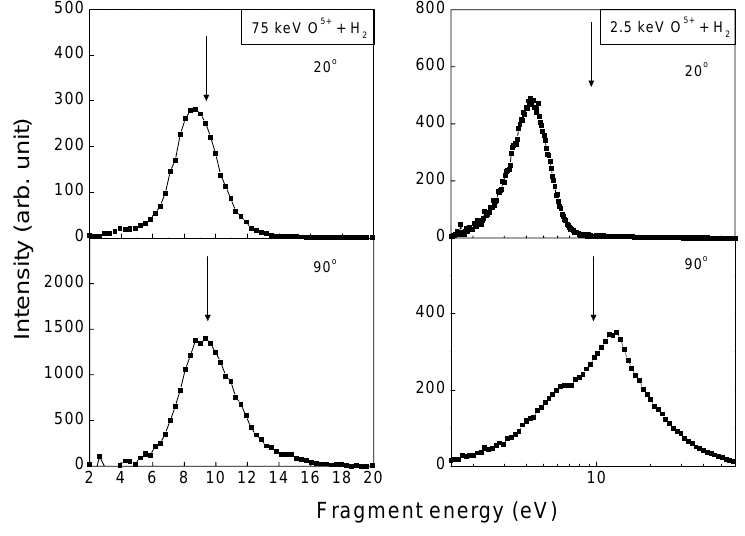
o o and 90 following the 5+ + H collisions. The arrow indicates 2